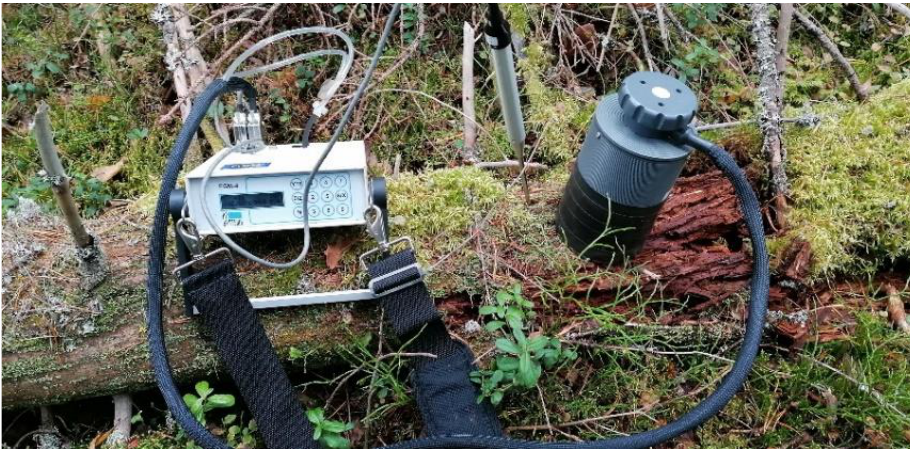
Figure 8. Portable infrared gas analyzer operating in closed-path mode for the in situ measurement of CO 2 production from deadwood [35].